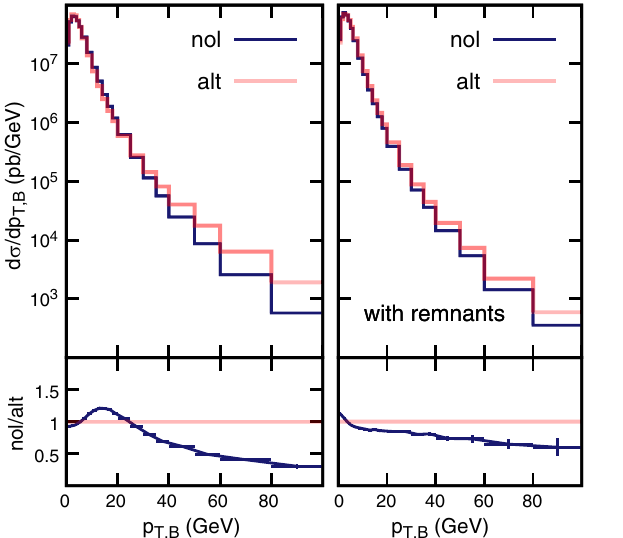
Fig. 11 Left panel: comparison of alt and nol for the transverse momentum distribution of the B hadron 8TeV LHC. Right panel: same comparison with the treatment of the enhanced regions using remnants, as discussed in the text